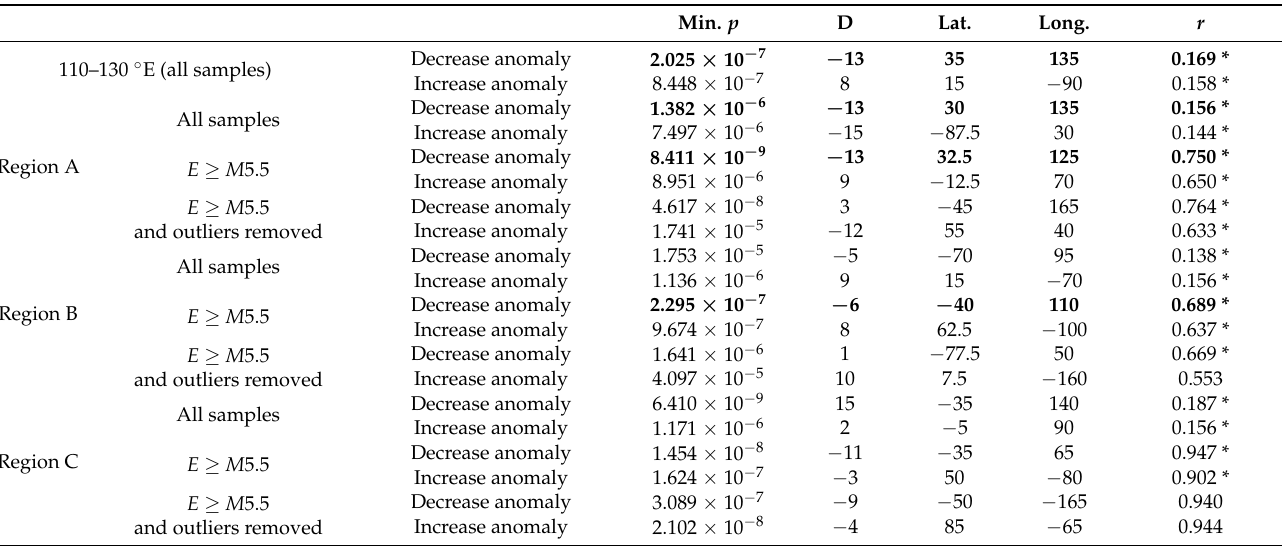
Table 3. The minimum p , associated D, locations, and r in analyses of this study shown in Supple- mentary Material